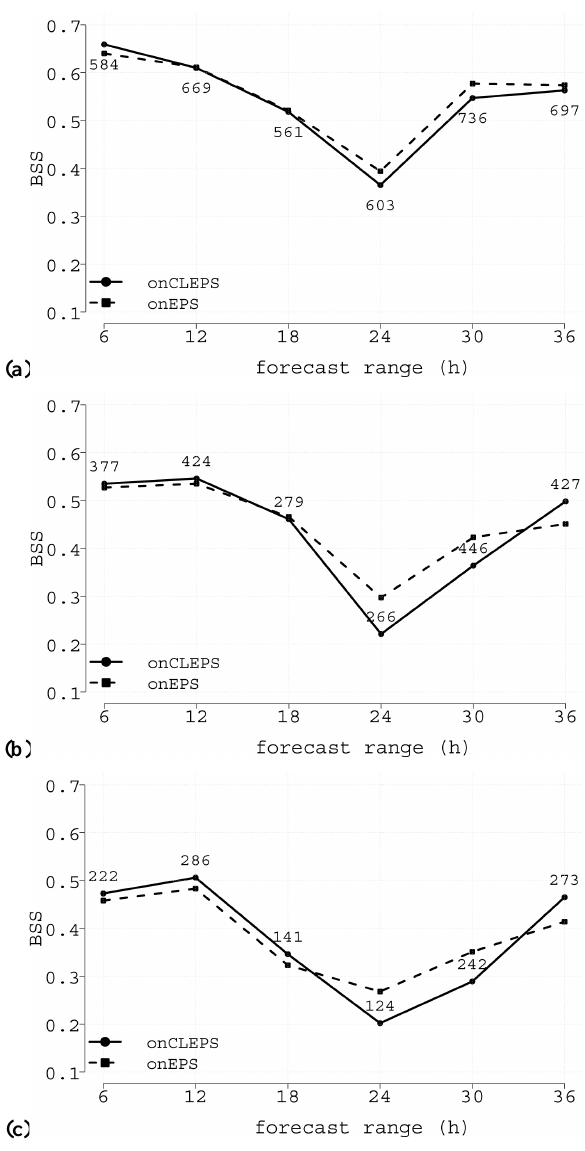
Fig. 9. The same as in Fig. 8 but for the Brier skill score. Thresholds are: 1mm (a) , 5mm (b) , and 10mm (c)